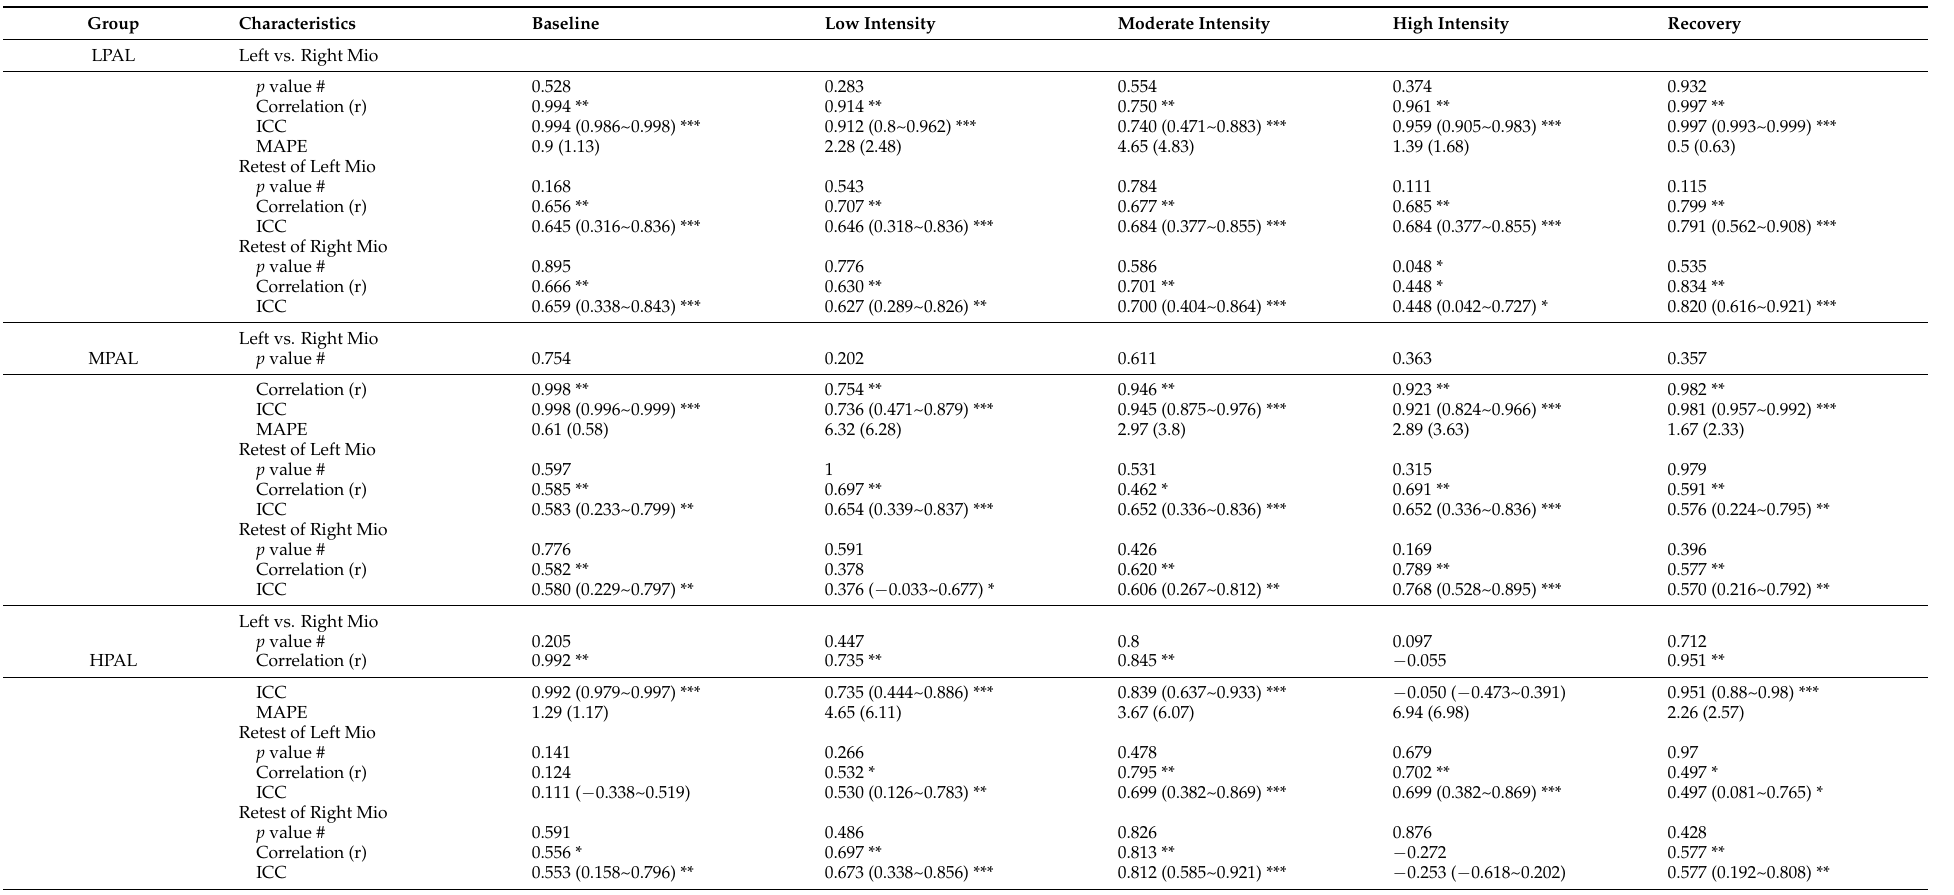
Table 4. Reliability of Mio for